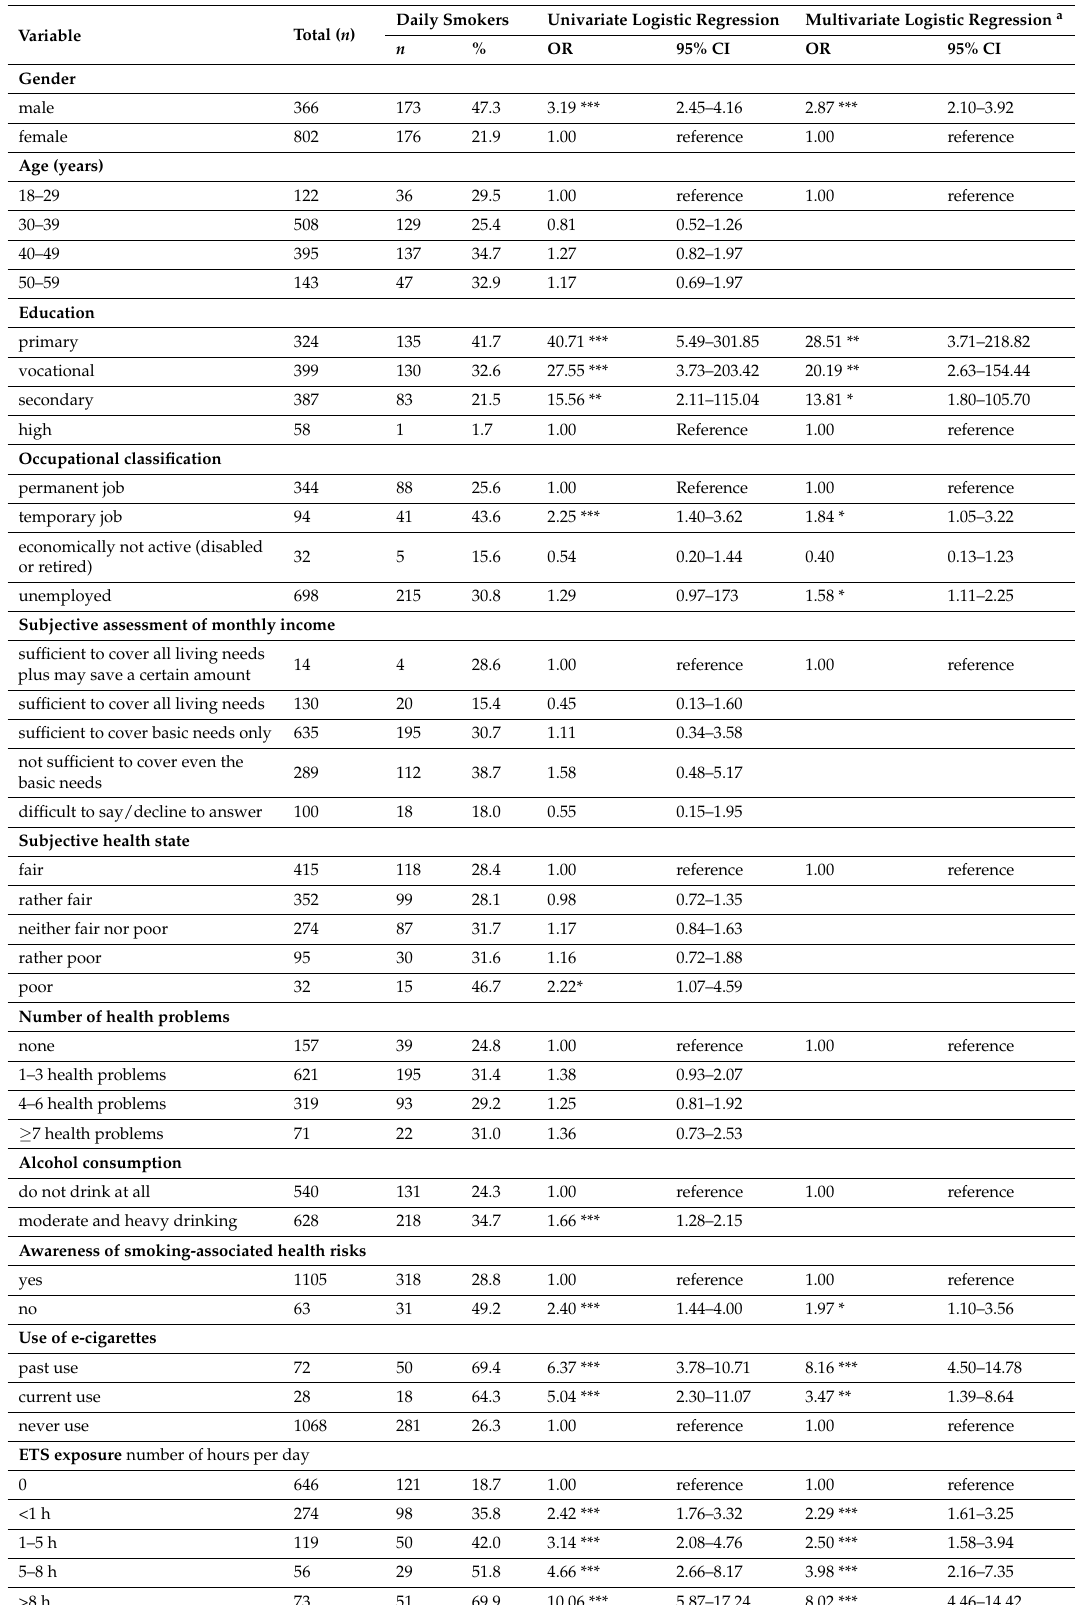
Table 4. Odds Ratios (OR) and 95% Confidence Intervals (CI) for daily smoking to selected socio- demographic characteristics in adult men and women from the Piotrkowski